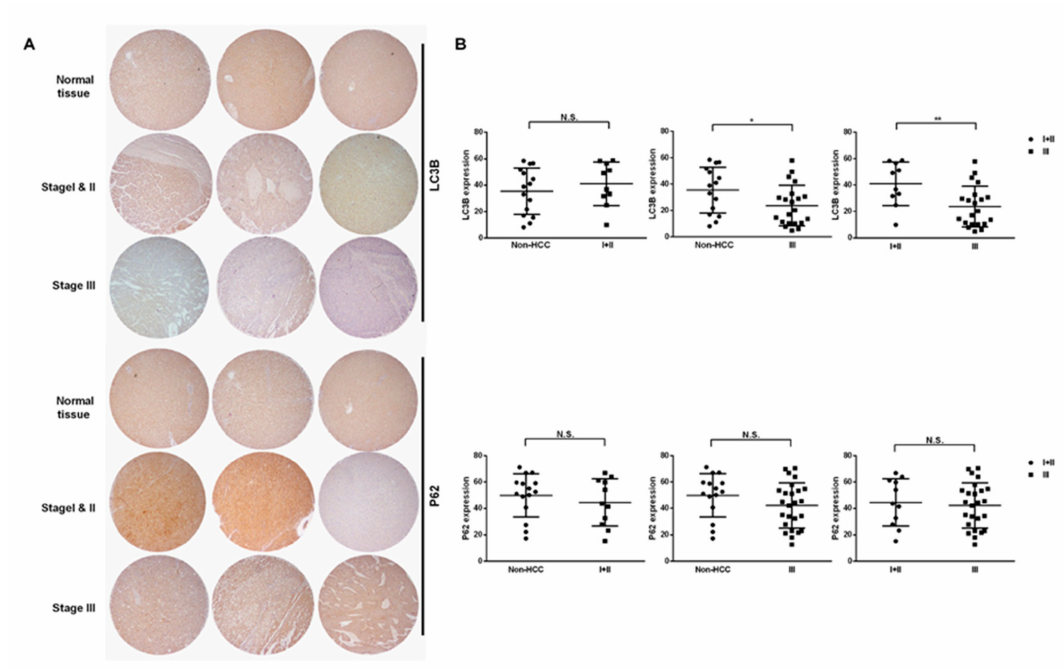
Figure 3. Low LC3B expression correlated positively with late stage hepatocellular carcinoma. ( A ) The expression levels of LC3B and P62 in stages I + II ( n = 10) and III ( n = 21) of tumor tissues and adjacent tissues ( n = 15) were detected by IHC. ( B ) Means of the measurements are shown with black lines. (NS: non-significant di ff erence, * p < 0.05, ** p < 0.01 compared with untreated normal